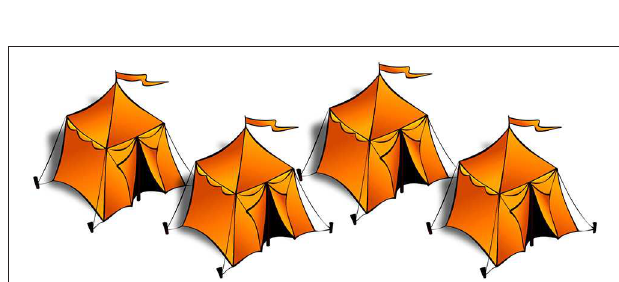
FIGURE 5 | Example of an image presented in the scalar implicature target condition. All four of the tents are orange, while the corresponding test sentence was Certaines tentes sont oranges “Some tents are